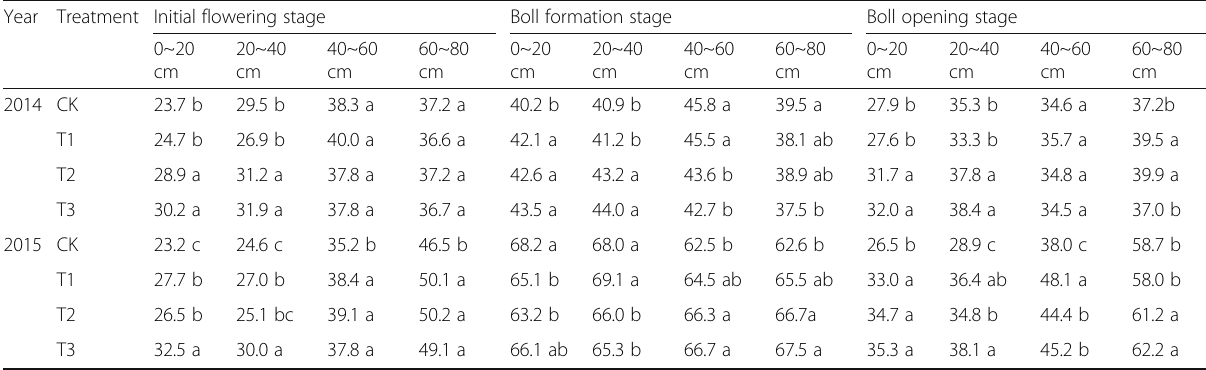
Table 2 Soil water stored in different soil layers at the initial flowering stage, boll formation stage, and boll opening stage of cotton in 2014 and 2015 (mm) Year Treatment Initial flowering